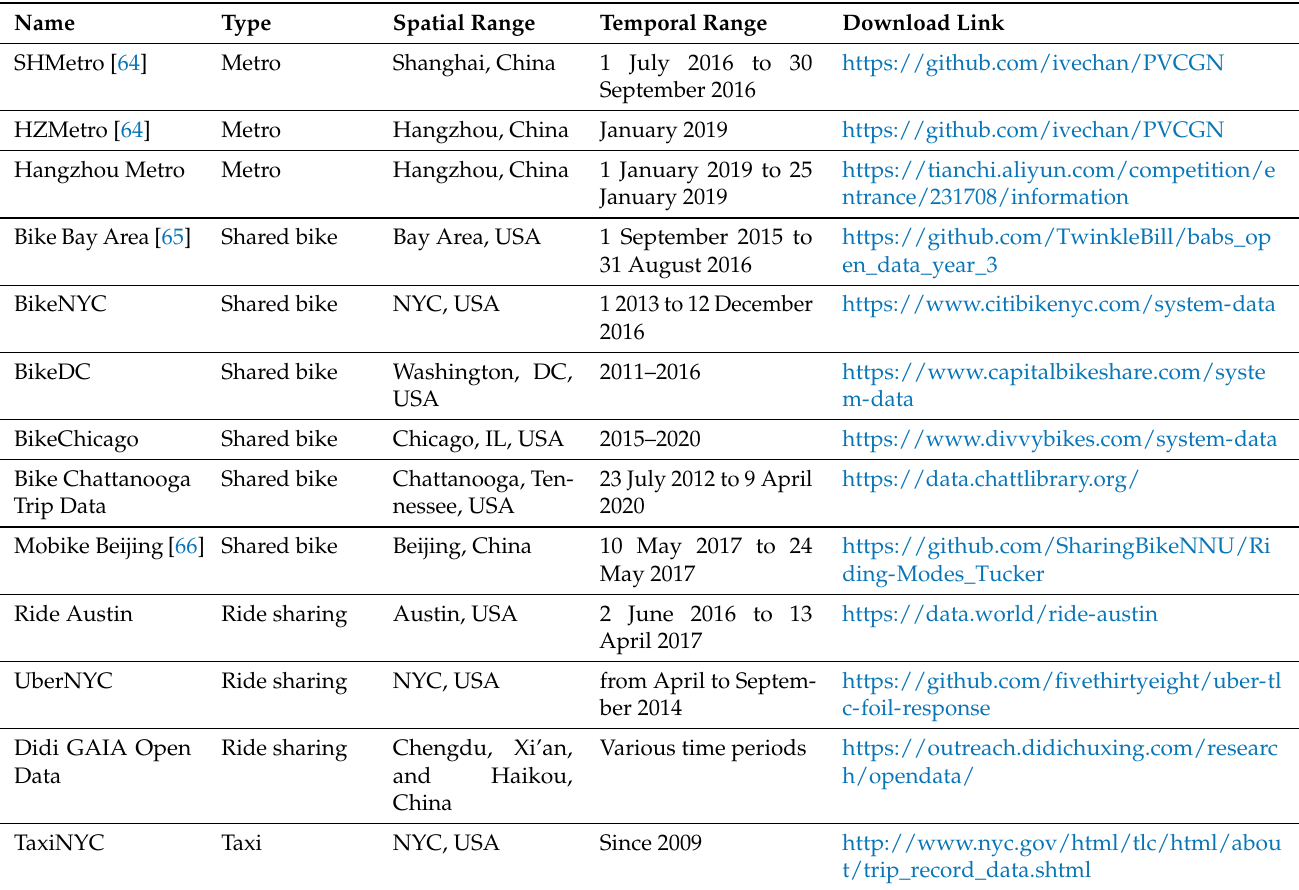
Table 7. The list of open public transport transaction